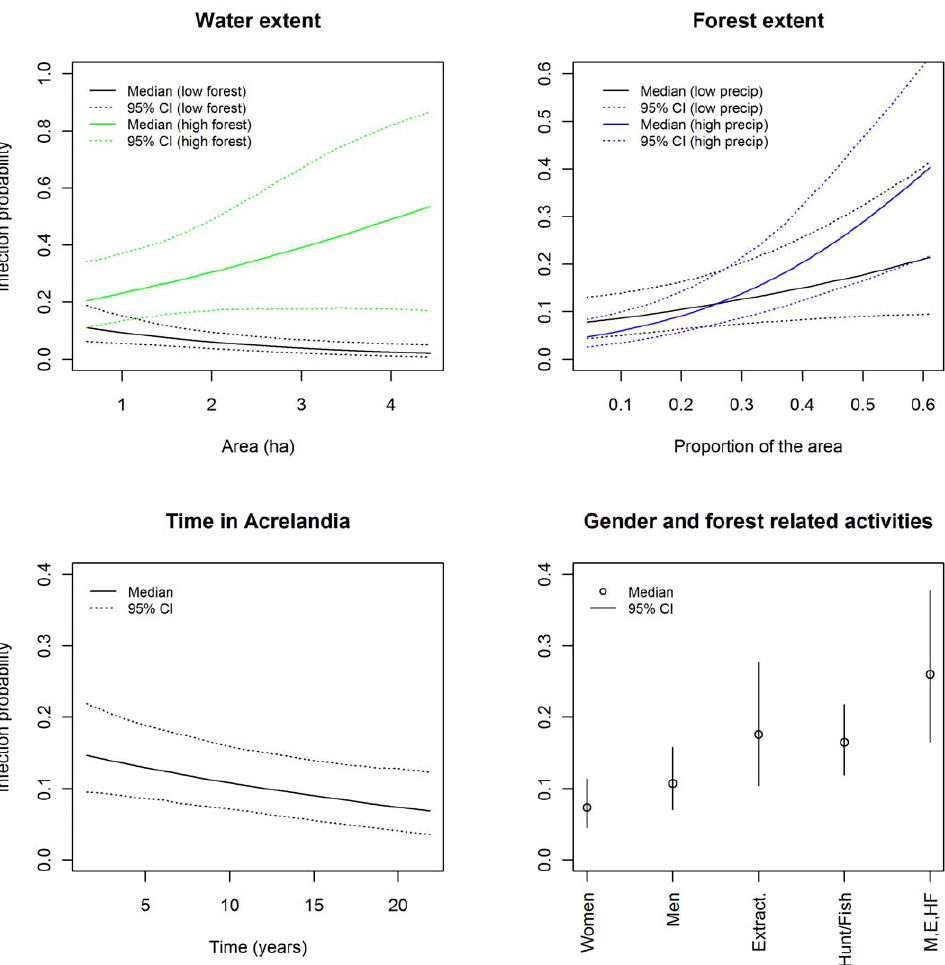
Figure 5. Probability of infection p I ~~ 1 ð Þ as a function of the most important covariates. The probability of infection was calculated with the other covariates fixed at their mean value. CI stands for credible interval. Lower right panel shows the independent effect of being a woman (‘Women’), being a man (‘Men’), participating on extractivism activities (‘Extract.’), and participating on hunting or fishing activities (‘Hunt/Fish’). The summed effect of being a man, partipating on extractivism and hunting/fishing activities is also shown